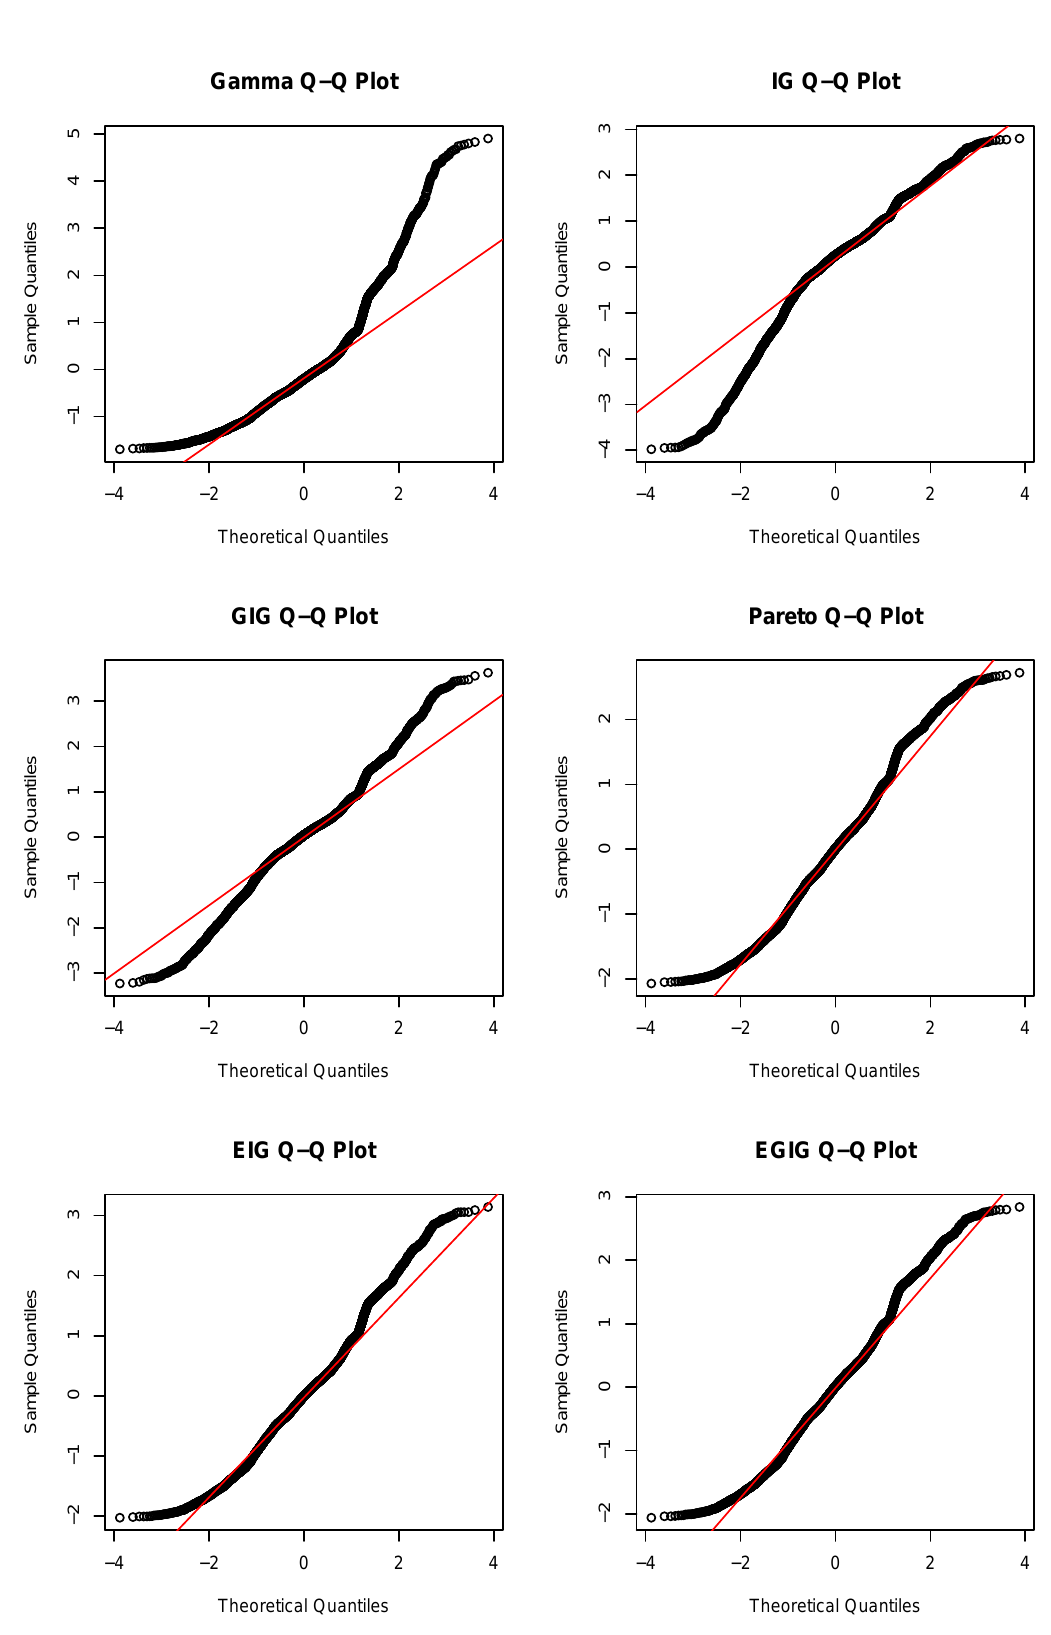
Figure 1. Quantile–quantile (QQ) plots of fitted